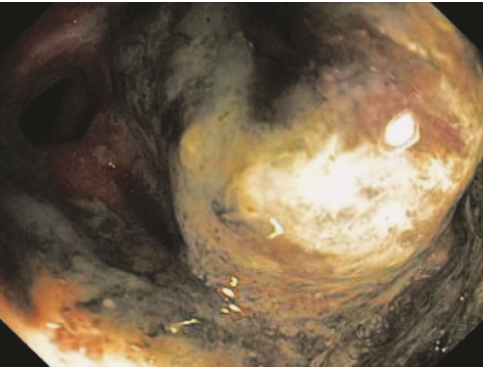
Figure 16: Endoscopic image of ischemic colitis involving the ileocecum. The appendix and appendiceal orifice are marginally spared and appear relatively normal.